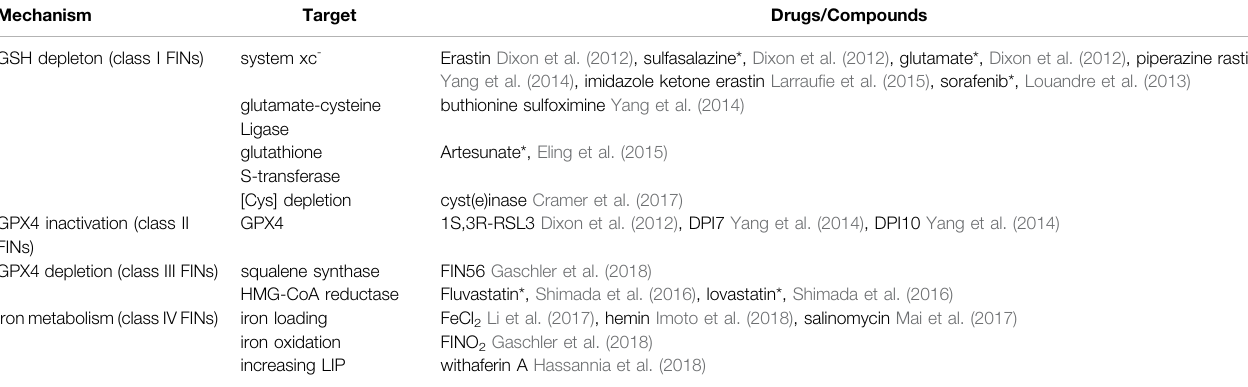
TABLE 2 | Ferroptosis